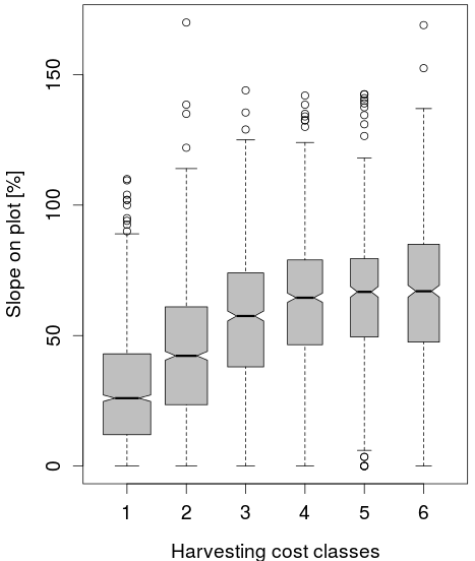
Figure 2. Slope dependent harvesting costs for Switzerland. Harvesting cost classes correspond to: (1) till 50 CHF/m 3 ; (2) 51–75 CHF/m 3 ; (3) 76–100 CHF/m 3 ; (4) 101–125 CHF/m 3 ; (5) 126–150 CHF/m 3 ;